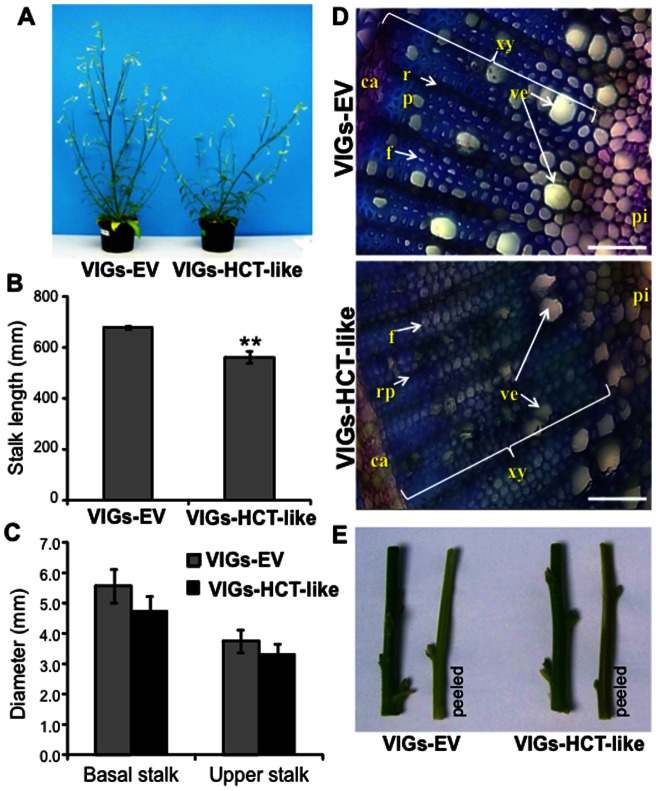
Growth, stem ultrastructure and reduced lignin deposition of VIGs-HCT-LIKE compared to that of VIGs-EV plants.(A) HCT-LIKE-silenced plants have strongly altered morphology with reduced stalk lengths and leaning “rubbery” stem phenotypes. (B) Stalk length and (C) basal and upper stalk (1 and 20 cm, respectively from the base of the stem) diameters of VIGS plants (n = 5 biological replicates) measured approximately 40 d after VIGS inoculation of plants (** P<0.01, Student's t-test). (D) High lignin deposition in EV (empty vector) stem sections as compared to in HCT-LIKE-silenced (VIGs-HCT-LIKE) stems. Observation made under bright field microscopy conditions after staining of hand sections with Toluidine blue O. ca, cambium; xy, xylem; rp, ray parenchyma; f, xylem fiber; ve, vessel; pi, pith. Bars  = 100 μm. (E) Intact and peeled stem segments of VIGs-EV and VIGs-HCT-like plants.